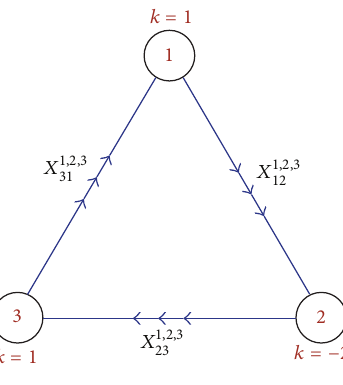
Figure 4: Quiver diagram for Fano B 4